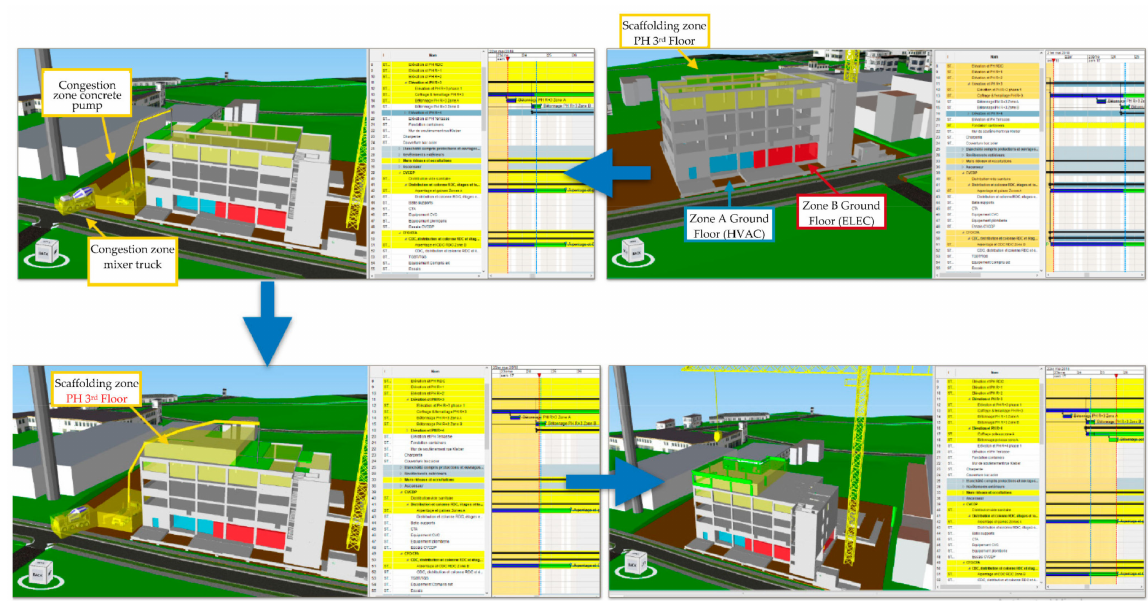
Figure 12. 4D BIM planning of the Nanterre 2 CESI project using the CESI